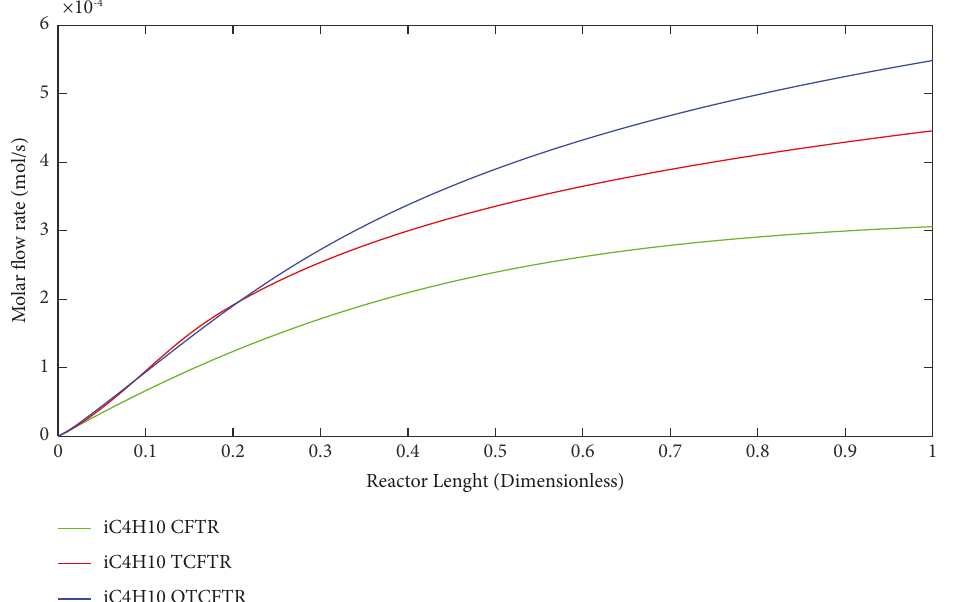
Figure 21: Comparison of the molar flow rate of isobutene in the exothermic part of the reactor for CFTR, TCFTR, and TCFTR